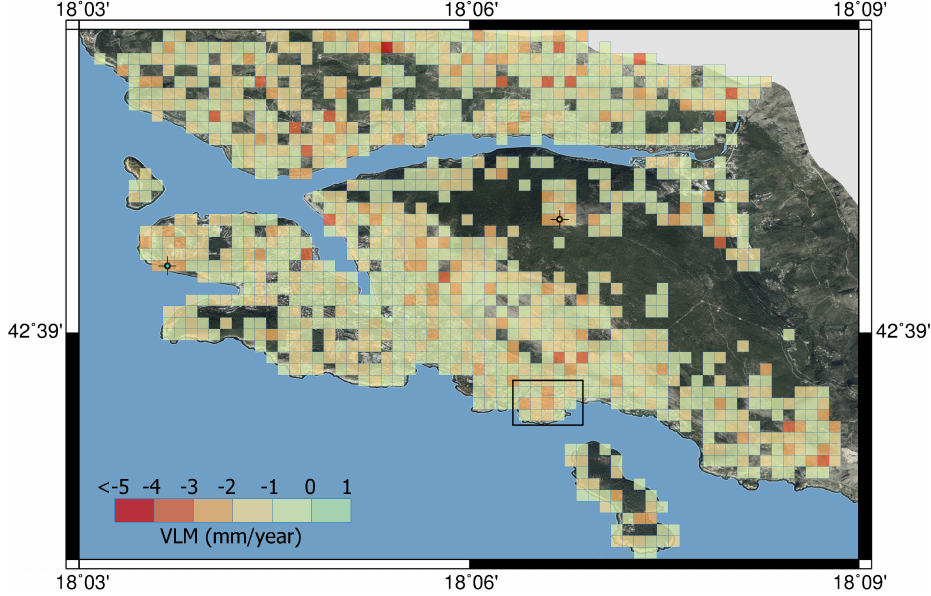
Figure 5. VLM trends computed from Sentinel-1 InSAR data for the period 2014–2020; each cell of approximately 100 × 100 m is represented by the weighted average of the VLM within the cell (3–15 estimates); the positions of the GNSS and tide gauge station are shown by the cross with yellow and cyan circle, respectively; the black box marks the old town of Dubrovnik; the orthophoto background map was downloaded from